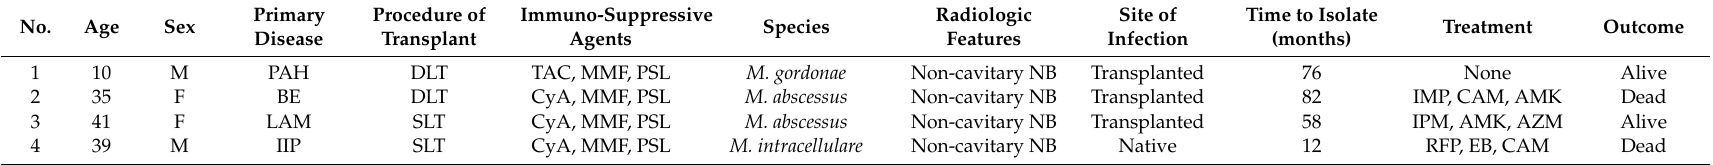
Table 1. Clinical characteristics and outcomes of patients with NTM infection after lung